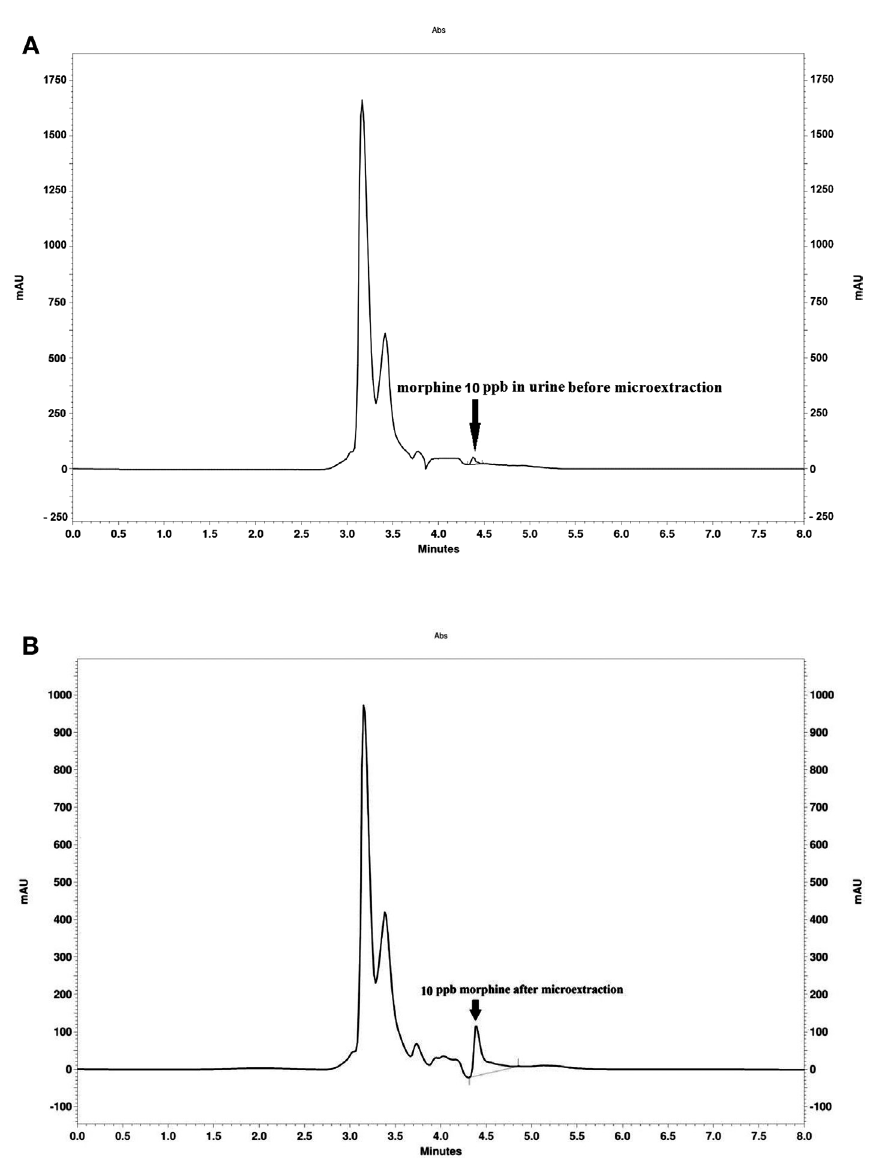
Figure 5: HPLC chromatograms of the morphine preconcentrated with the SPME method. The chromatograms show morphine peak before (a) and after microextraction